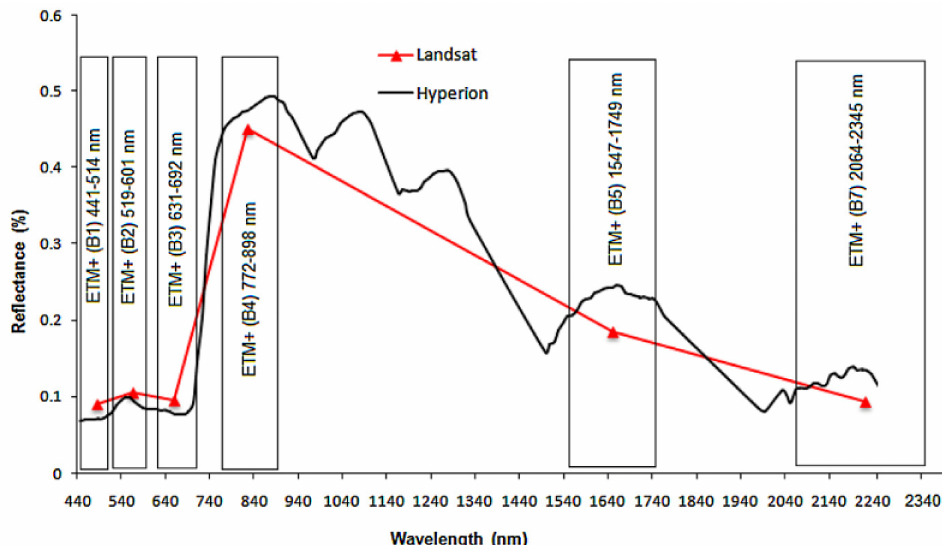
Figure 5. Spectral signatures of a representative sugarcane crop (provided by Hamzeh et al. [45]). The red triangles represent Landsat-7 ETM+ bands 1–5 and 7 (the red line is only drawn to enhance visibility), while the black line shows the 198 continuous spectral signatures based on hyperspectral bands from Hyperion (note that the straight segments of the black line are linear interpolations within the water vapor absorption